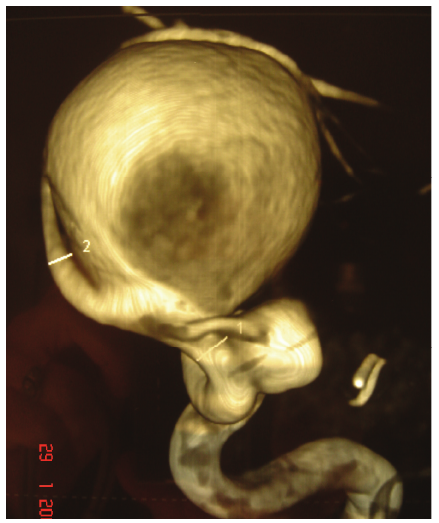
Figure 3: 3-dimensional digital angiography illustrating the double